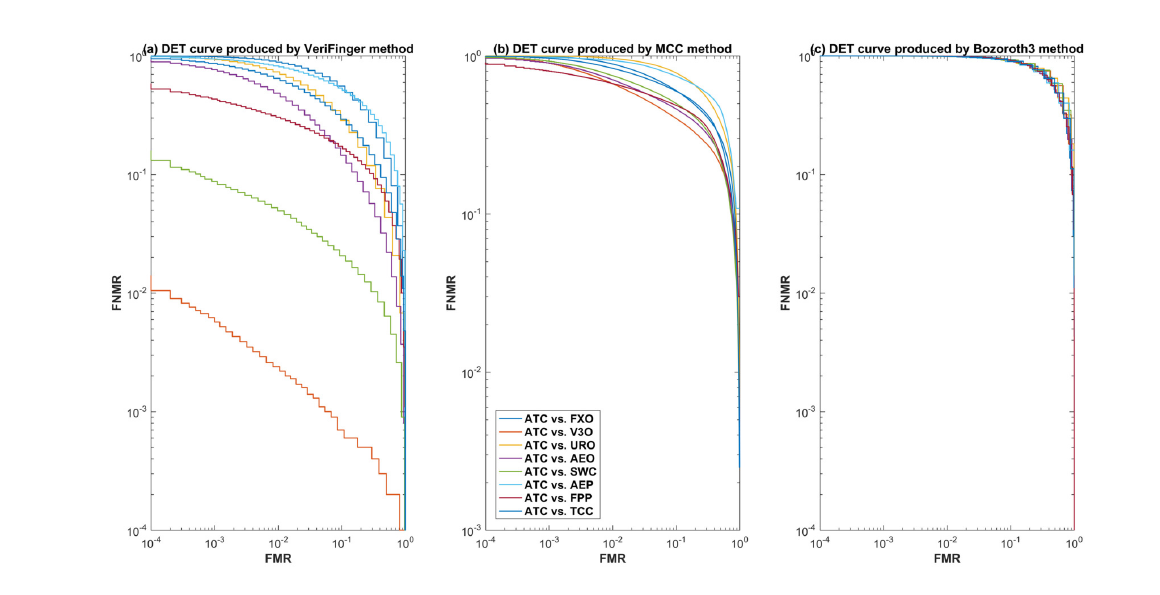
Figure 7. Detection error tradeoff (DET) curves of the three methods when ATC is used as a gallery set.